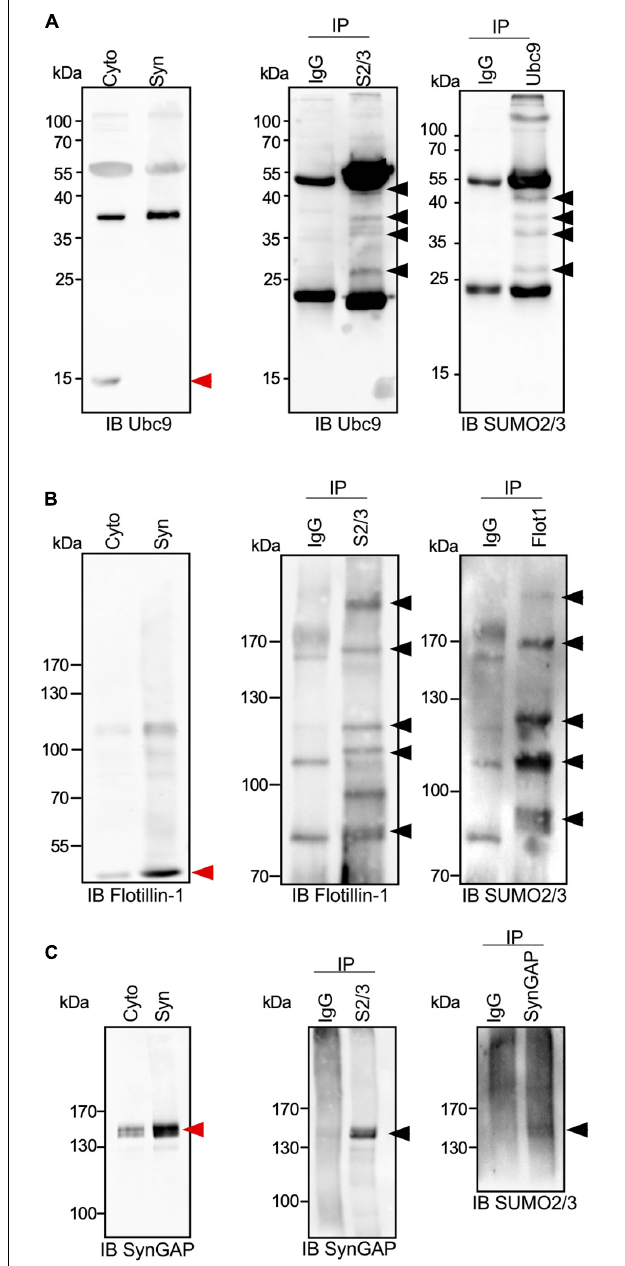
FIGURE 3 | SUMO2/3-ylation profile of Ubc9, Flotillin-1 and SynGAP at synapses. (A) Immunoblot anti-Ubc9 of cytoplasmic and synaptic extracts from PND14 rat brains (left panel). Representative immunoblot using Ubc9 antibody of synaptic SUMO2/3 or control IgG immunoprecipitated proteins (middle panel; n = 3 independent experiments) and immunoblot using SUMO2/3 antibody of synaptic Ubc9 or control IgG immunoprecipitated (right panel; n = 3 independent experiments). Similarly to (A) , immunoblot of cytoplasmic and synaptic extracts from PND14 rat brains (left panel), synaptic SUMO2/3 or control IgG immunoprecipitated proteins (middle panel; n = 3 independent experiments) and the converse immunoprecipitation (right panel; n = 3 independent experiments) were done for Flotillin-1 (B) and SynGAP (C) . Black arrows indicate SUMO2/3-ylated forms of the different SUMO targets and red arrows indicate the unmodified